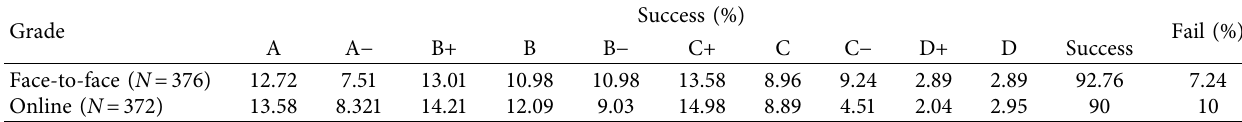
Table 3: Semester total grade